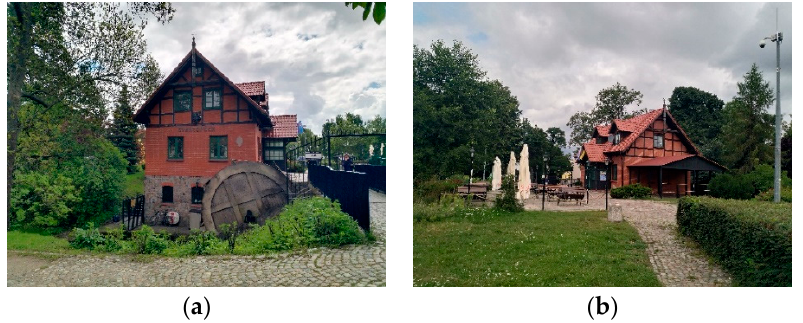
Figure 7. The water mill—a restaurant in the place of historic forge. ( a ) View from the riverside.